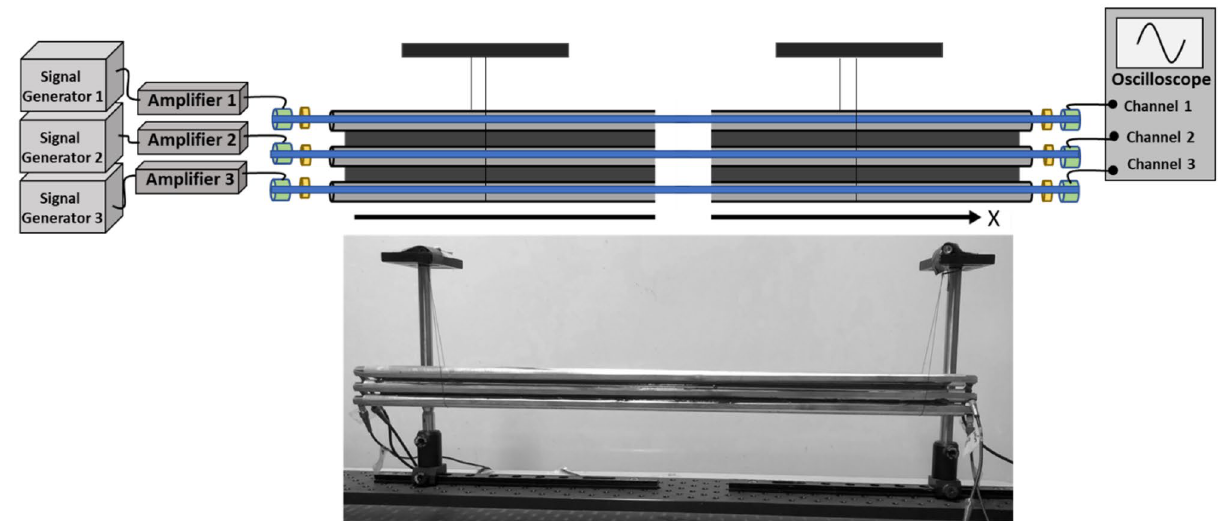
Figure 1. Picture and exploded-view of an array of three acoustic waveguides coupled with epoxy resin and schematic illustration of the experimental system for generating and detecting logical phi-bits. Three separate signal generators and amplifiers are used to drive piezoelectric transducers. Driving and detecting transducers are attached to the opposite ends of the rod-like acoustic waveguides by the pressure of three independent rubber bands. A thin layer of honey is used as ultrasonic coupling agent between the transducers and the rod ends. The signals generated by the detecting transducers enter an oscilloscope via independent input channels for analysis. The array of waveguides is suspended by thin threads for